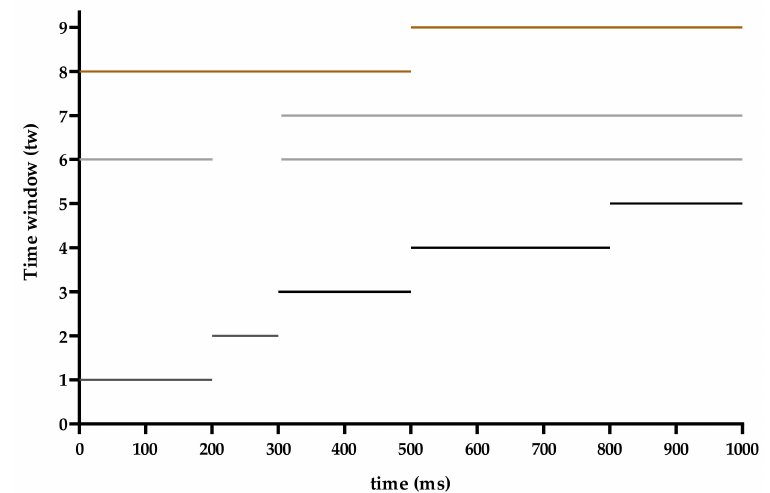
Figure 3. The time interval corresponding to Time windows (tw1–9). The x-axis represented time selection. The y-axis represented